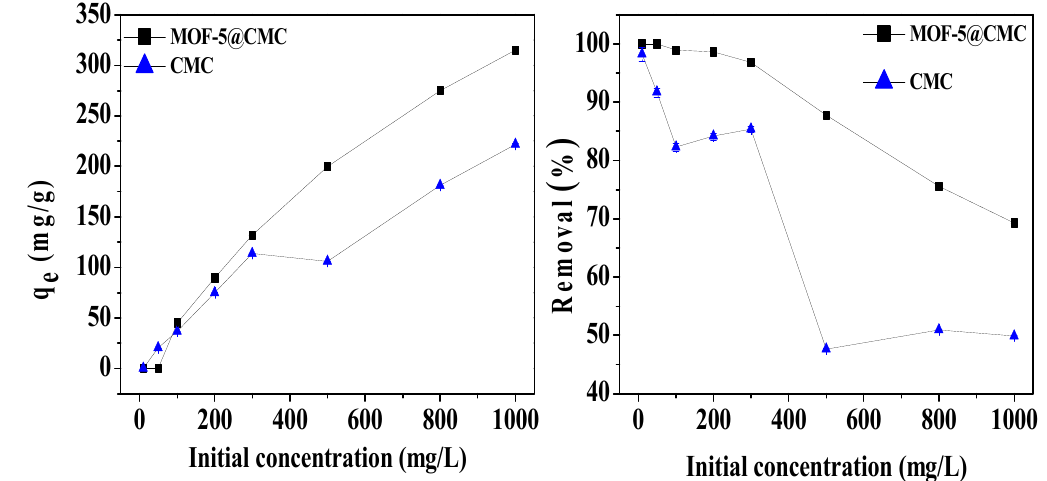
Figure 8. The action of initial Pb(II) concentration on adsorption capacity and removal rate.